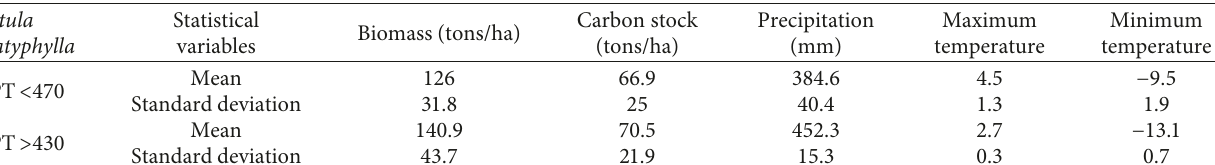
Table 2: Mean and standard deviation of stem biomass, carbon stock, precipitation, and temperature variables on precipitation > 430mm and < 430mm of Betula platyphylla across the geographic regions of Daxing’anling Mountain of Inner Mongolia, China. Betula